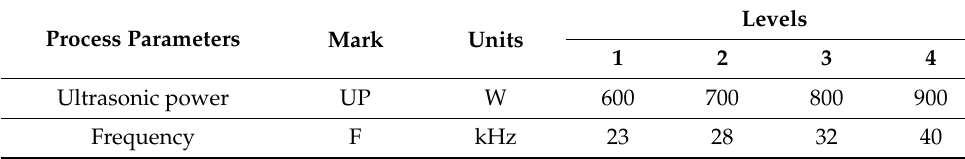
Table 2. Experimental factors and levels.